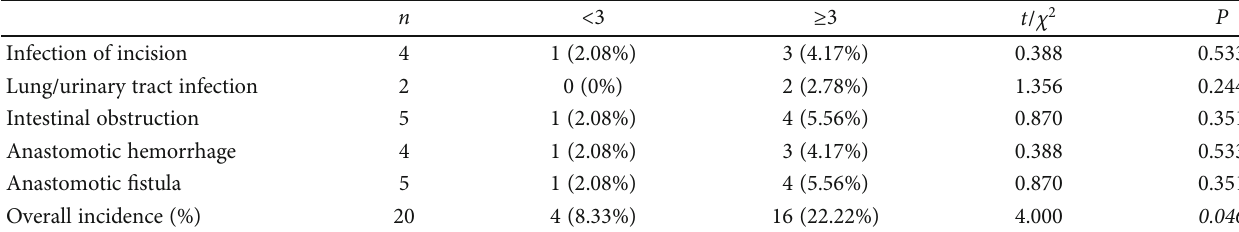
Table 2: Comparison of postoperative complications between the two